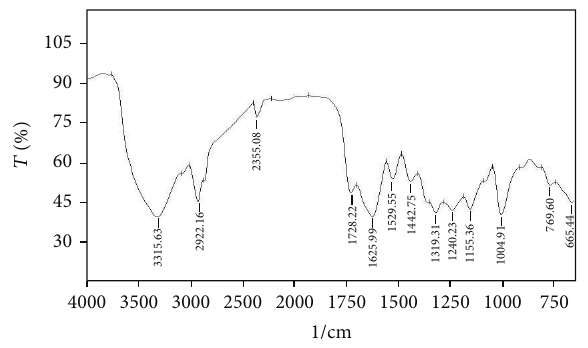
Figure 7: FT-IR spectrum of treated